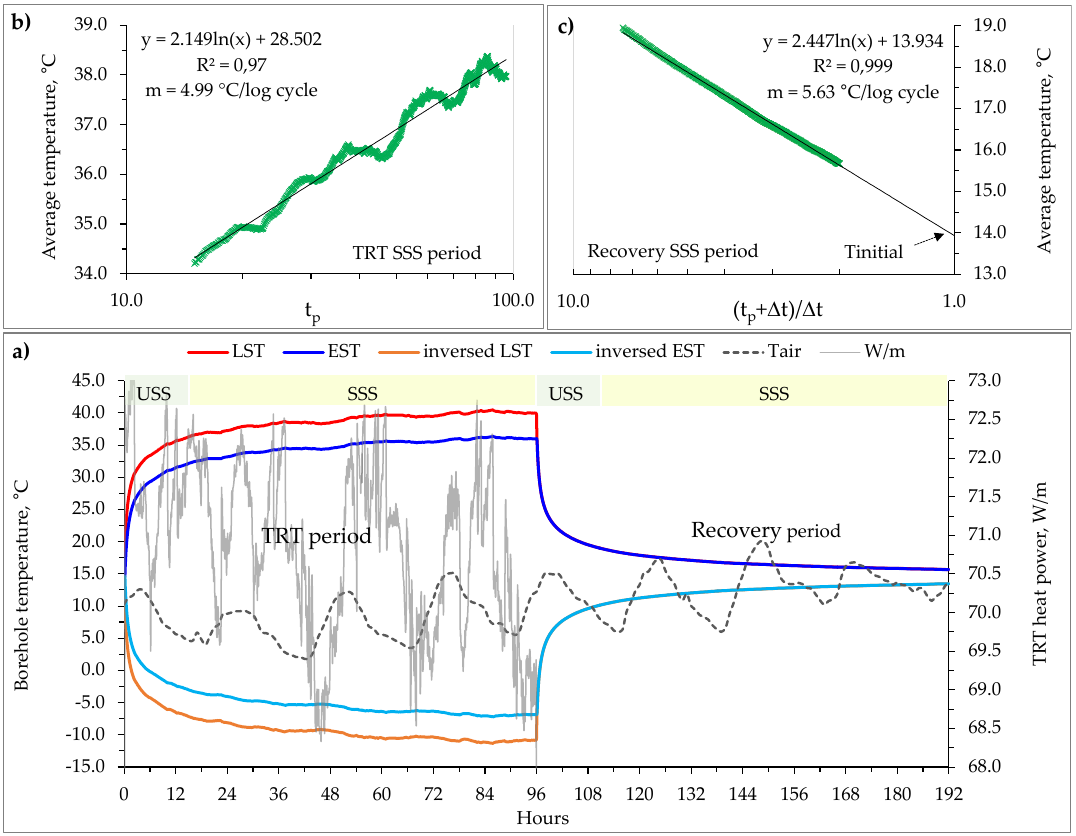
Figure 6. Example of two-step TRT analysis carried out for each heat power condition (CXC 71 W/m presented here); ( a ) Recorded borehole and air temperatures and unit heat power; ( b ) Determination of conductivity from TRT period; ( c ) Determination of conductivity by Horner’s method from recovery period.